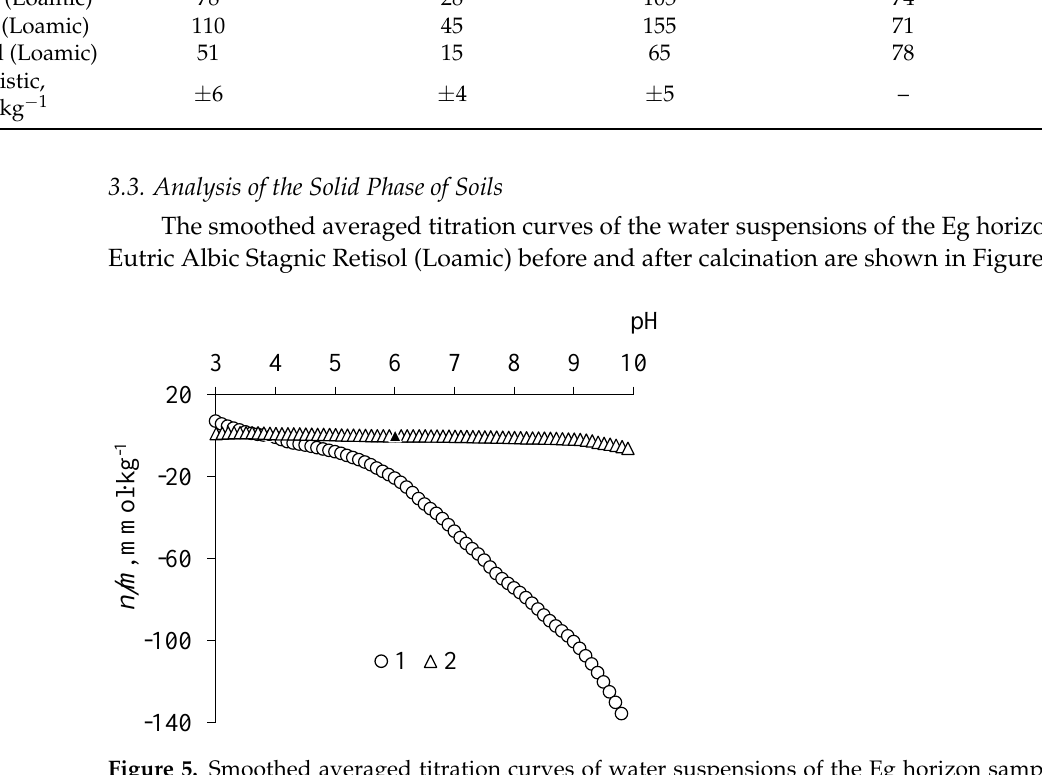
Table 2. The number of acid groups of compounds extracted by distilled water. Total Number Of Groupings, The Molar Fraction of the Soil